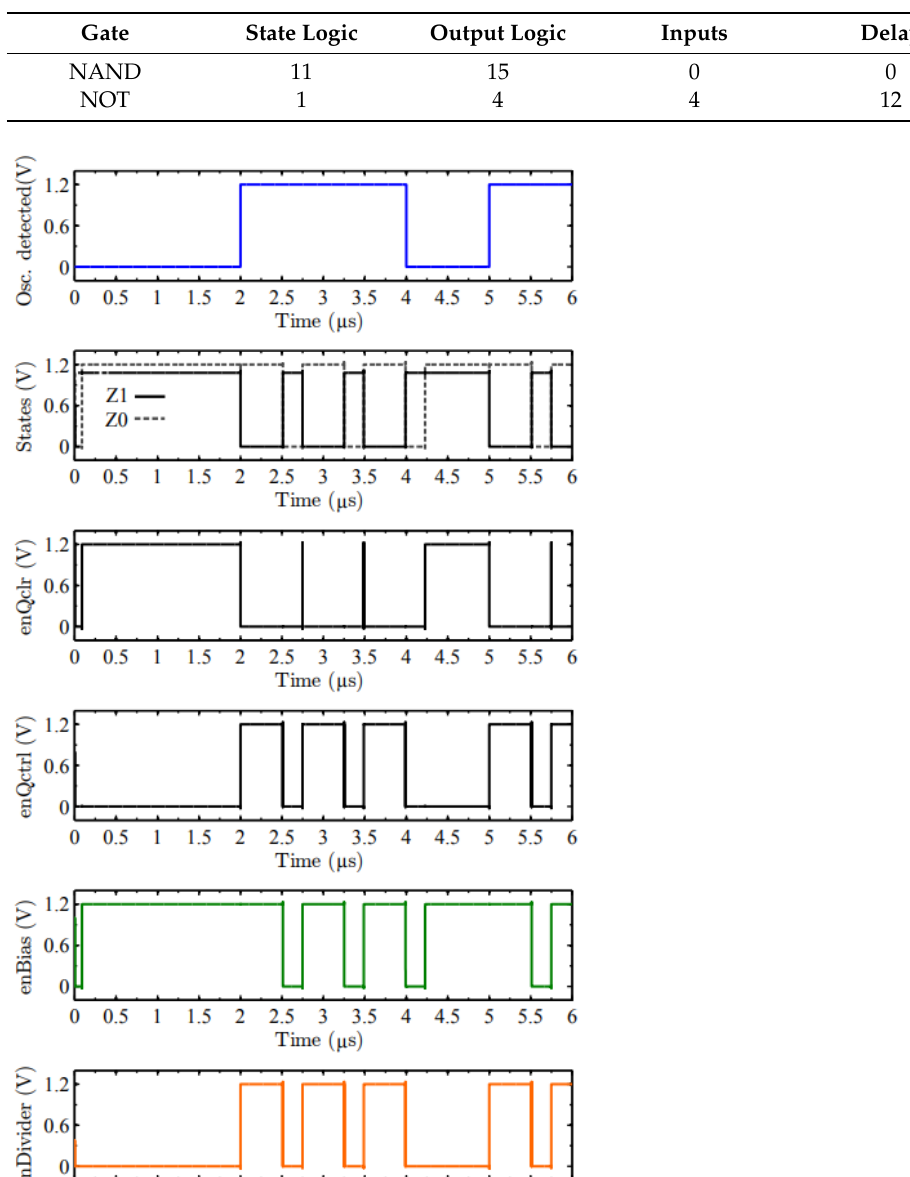
Table 1. Number of gates for state machine.